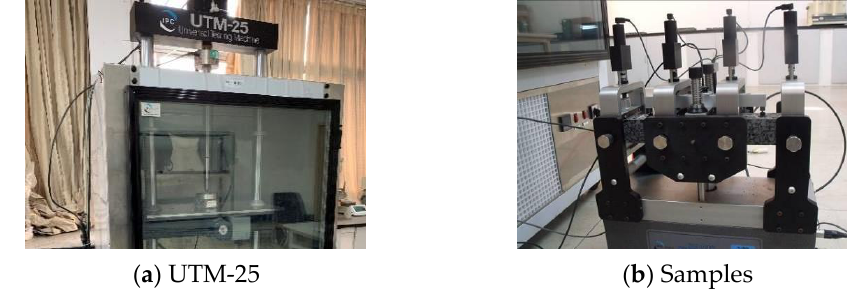
Figure 4. Four-point bending fatigue